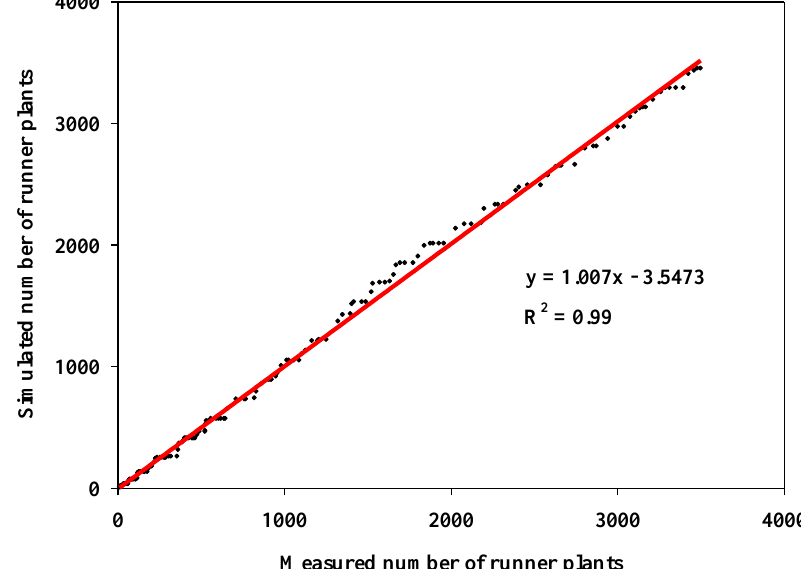
Figure 4. Time course of cumulated numbers of runner plants measured for 365 days and simulated by a program to predict number of transplants for autotrophic transplant production method. The runner plants were annually produced from nine initial propagules in 3.6 m 2 propagation area (five cultivation beds; maximum capacity number of propagules: 160) and the simulated result was also simulated by the same conditions as measured one. RMSEs between measured and simulated results were 15.9 on the exponential increasing section (0 to 70 days) and 65.1 on the linear increasing section (71 to 365 days).